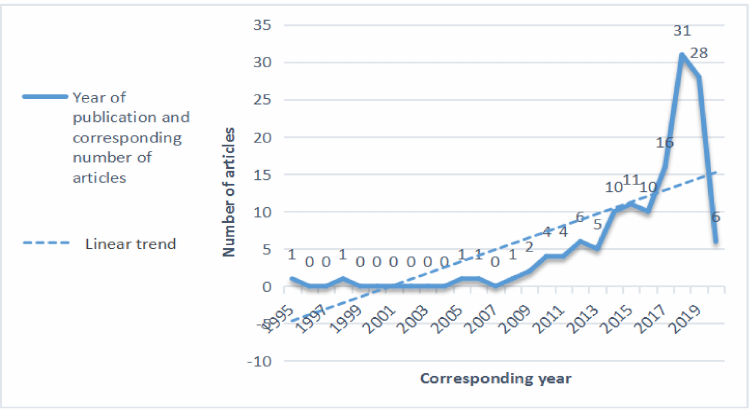
Figure 2. The number of publications in different years